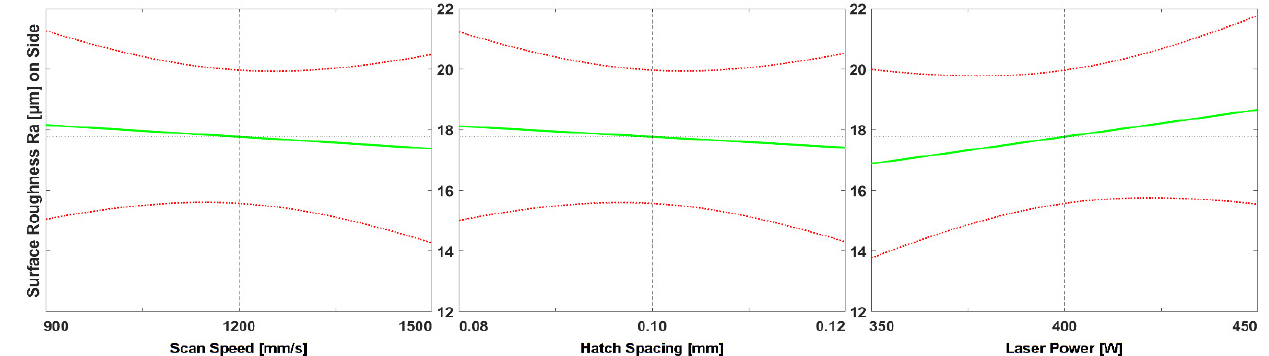
Figure 10. Predicted effects of changes in process parameters on the roughness R a on the side sur- face, where the green lines are the predictions of surface roughness on side surfaces and the dotted red lines present the 95% confidence bounds. lines present the 95% confidence bounds.